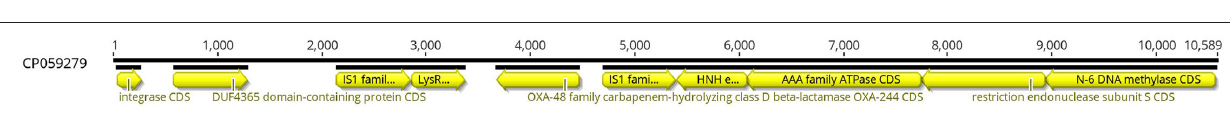
FIGURE 10 | Schematic representation of the 10,578 bp genetic segment representing the genetic environment of chromosomally encoded bla OXA-244 harbored in the IS1-made composite transposons.